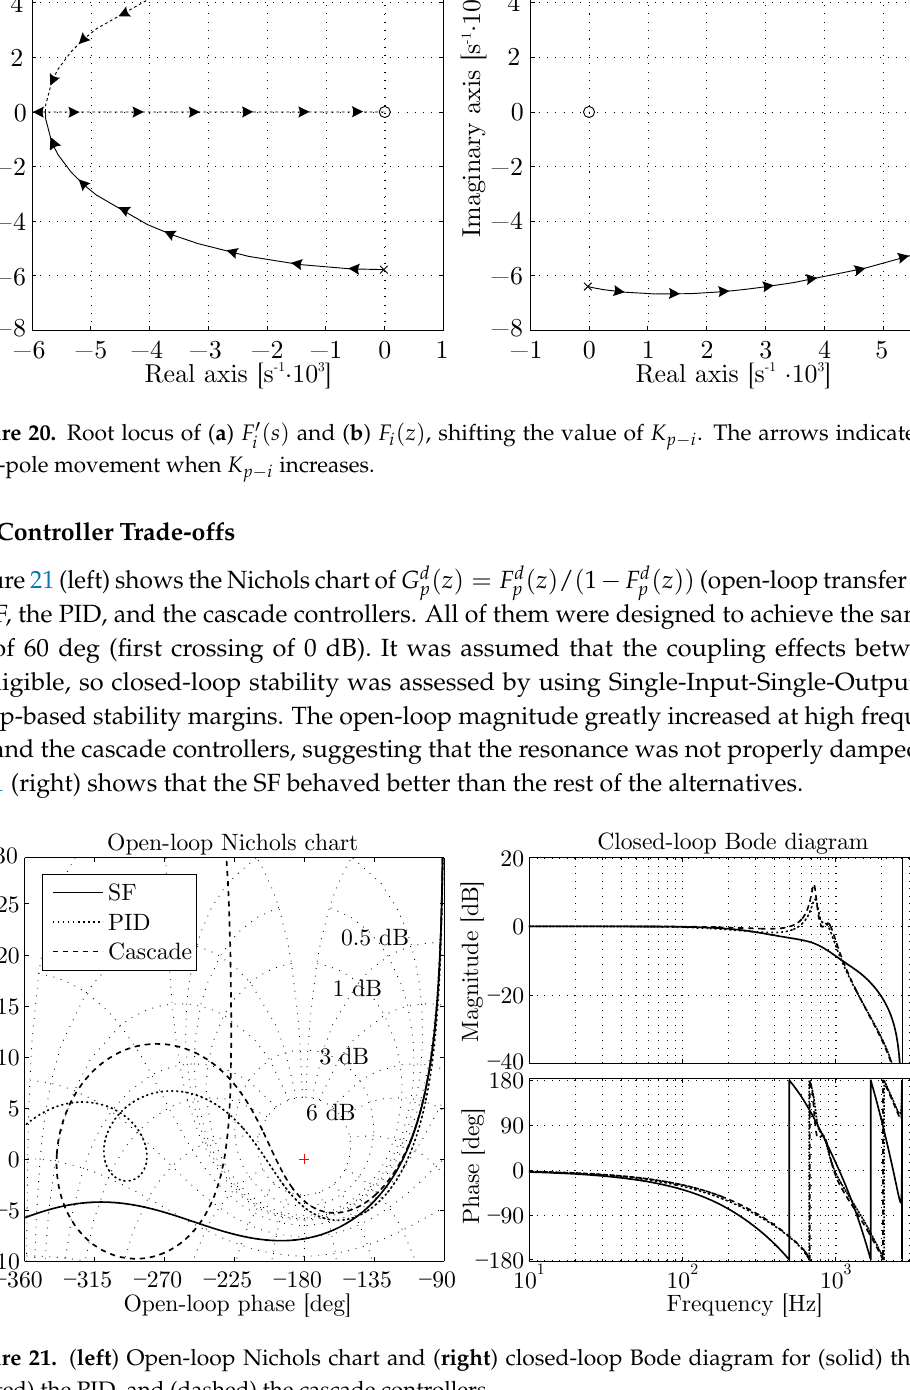
Figure 21. ( left ) Open-loop Nichols chart and ( right ) closed-loop Bode diagram for (solid) the SF, (dotted) the PID, and (dashed) the cascade